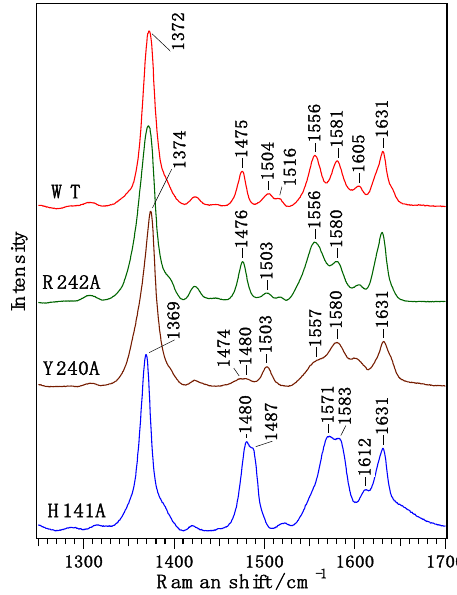
Figure 4. Resonance Raman spectra of WT, H141A, Y240A, and R242A CgHmuT in the high frequency region.